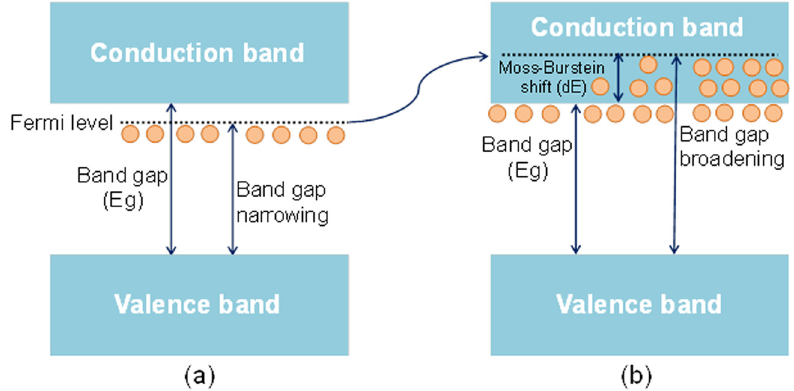
Figure 4: ( a ) Band gap narrowing of 0.5 – 1.0 wt% La - doped ZnO, and ( b ) band gap broadening for 1.5 wt% of La - doped